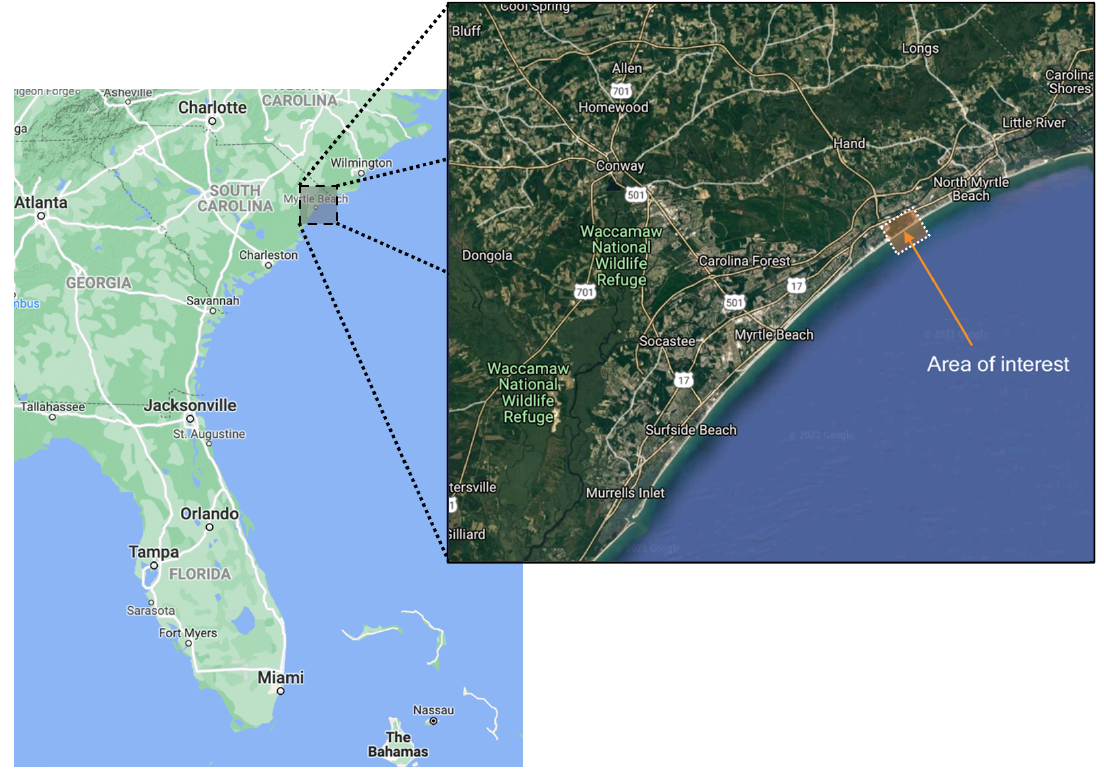
Figure 21. Location of area of interest in the Myrtle Beach test case. Source: © Google Maps 2021.